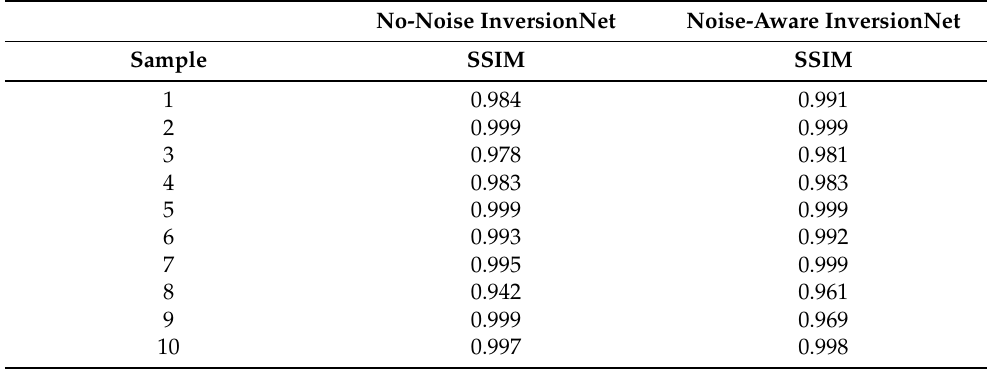
Table 2. Test performance achieved on the raspberry pi by InversionNet model on Kimberlina